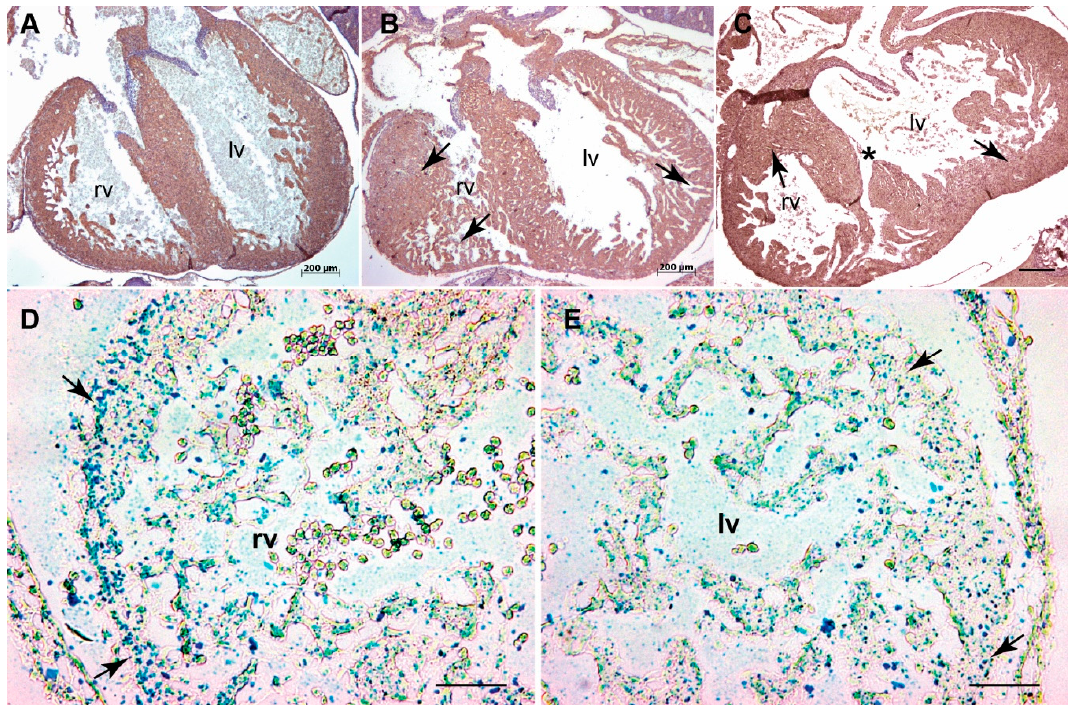
Figure 1. Tgfb3 deletion leads to an impaired myocardium in mouse embryos. A – C , Cross- sections of E15.5-16.5 fetuses showing cardiac muscle actin (clone HHF35) immunohistochemistry for wildtype ( A ) and two different TGF β 3-deficient fetuses ( B – C ). TGF β 3-deficient fetuses developed non-uniform right ventricular myocardium with heterogeneous regions of thicker ( B , left arrow) and thinner ( B , bottom arrow) myocardium and spongy ( B , right arrow) and thicker ( C , right arrow) left ventricular myocardium compared to the wildtype littermate fetus ( A ), Other mutant fetus had a muscular ventricular septal defect (VSD) ( C , asterisk) ( n = 6). D – E , Representative images revealed Tgfb3 expression (green-blue punctate dots, arrows) in the compact and trabecular myocardium of the right ( D ) and left ventricles ( E ) from wildtype E12.5 embryo . Scale bars = 200 μ m for A – C , 50 μ m for D – E . Abbreviations: rv, right ventricle; lv, left ventricle.